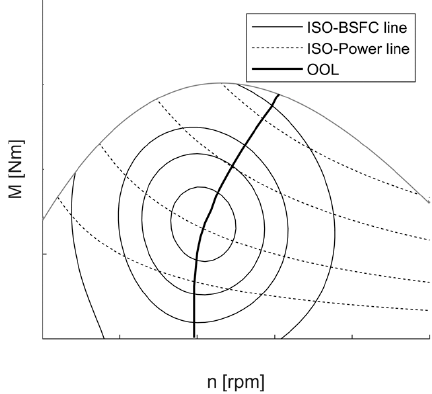
Figure 2. Engine map: iso-BSFC lines, iso-power lines, and optimal operating